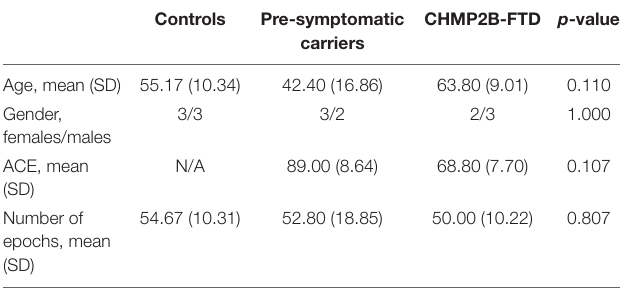
TABLE 1 | Characteristics of study